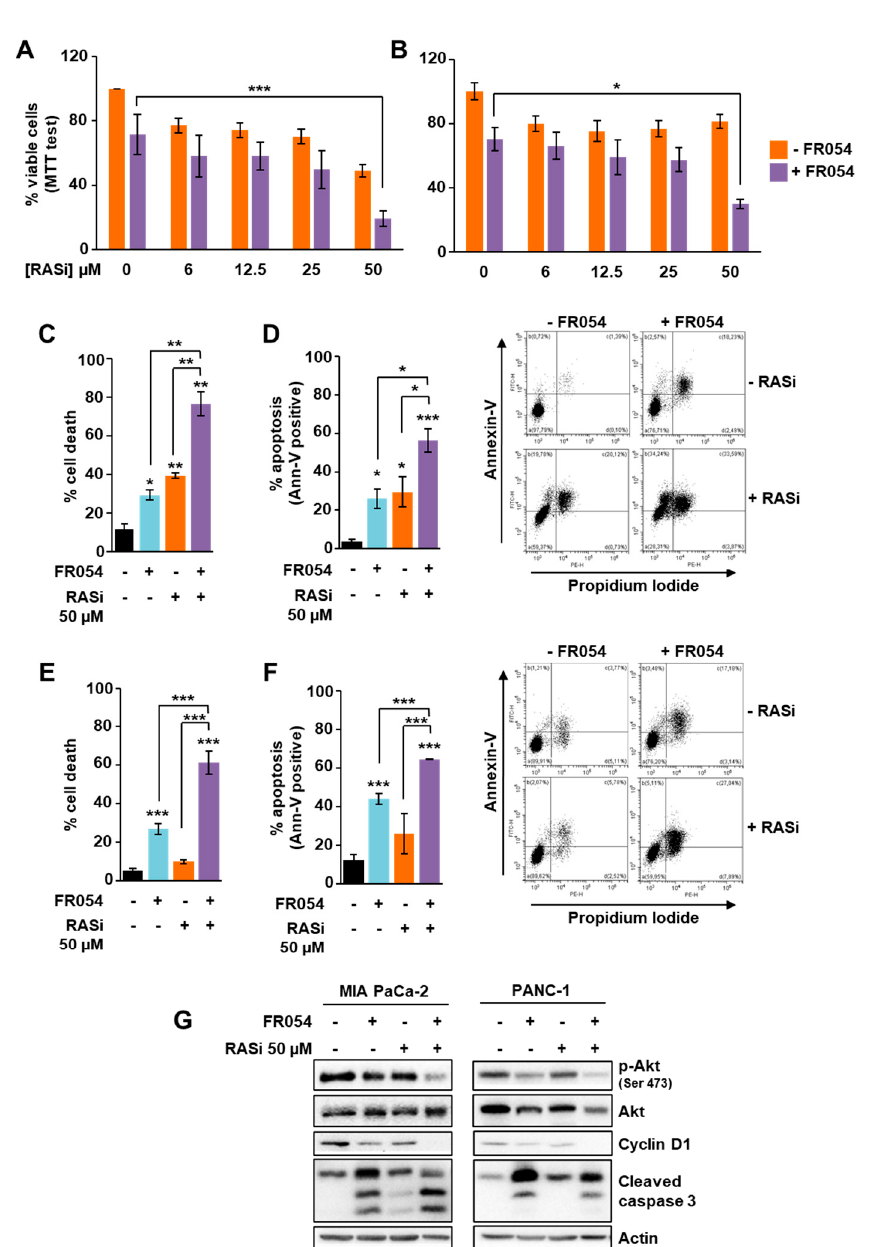
Figure 5. In KRASmut MIA PaCa-2 and PANC-1 cells, FR054 and the pan-RAS inhibitor BI-2852 present additive negative effects on cell proliferation and survival. ( A , B ) Cell viability of MIA-PaCa-2 and PANC-1, treated for 72h with FR054 (350 μ M for MIA-PaCa-2, 500 μ M for PANC-1) and different doses of RAS inhibitor BI-2852 (RASi), was detected through MTT test. ( C – G ) MIA PaCa-2 and PANC-1 were treated with FR054 and 50 μ M BI-2852 for 72 h. ( C – E ) Cell death was evaluated by viable count using Trypan Blue stain ( C , E ) and by using flow cytometric analysis of annexin V-FITC and propidium iodide staining ( D , F ). Representative profiles of the flow cytometric analysis are shown on the right of the panels ( D , F ). ( G ) The protein expression was analyzed through Western blotting. Actin was used for signal normalization. All data represent the mean ± SEM of at least three independent experiments. * p < 0.05, ** p < 0.01 and *** p < 0.001 (One-way ANOVA), untreated vs. treated where not specifically